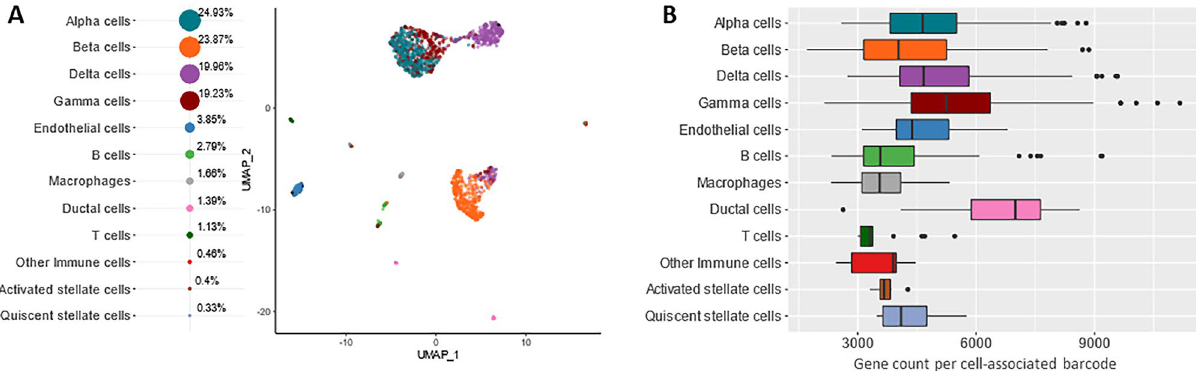
Figure 3. Analysis of pancreatic islet cells. ( A ) Pancreatic islet cells (176,000 raw reads per cell) automatically classified into cell types (left) following the same methodology as in Fig. 2B except for the reference dataset BaronPancreasData 30 . ( B ) Box plots showing the distribution of gene diversity per identified cell type for pancreatic islet cells classified in ( A ).